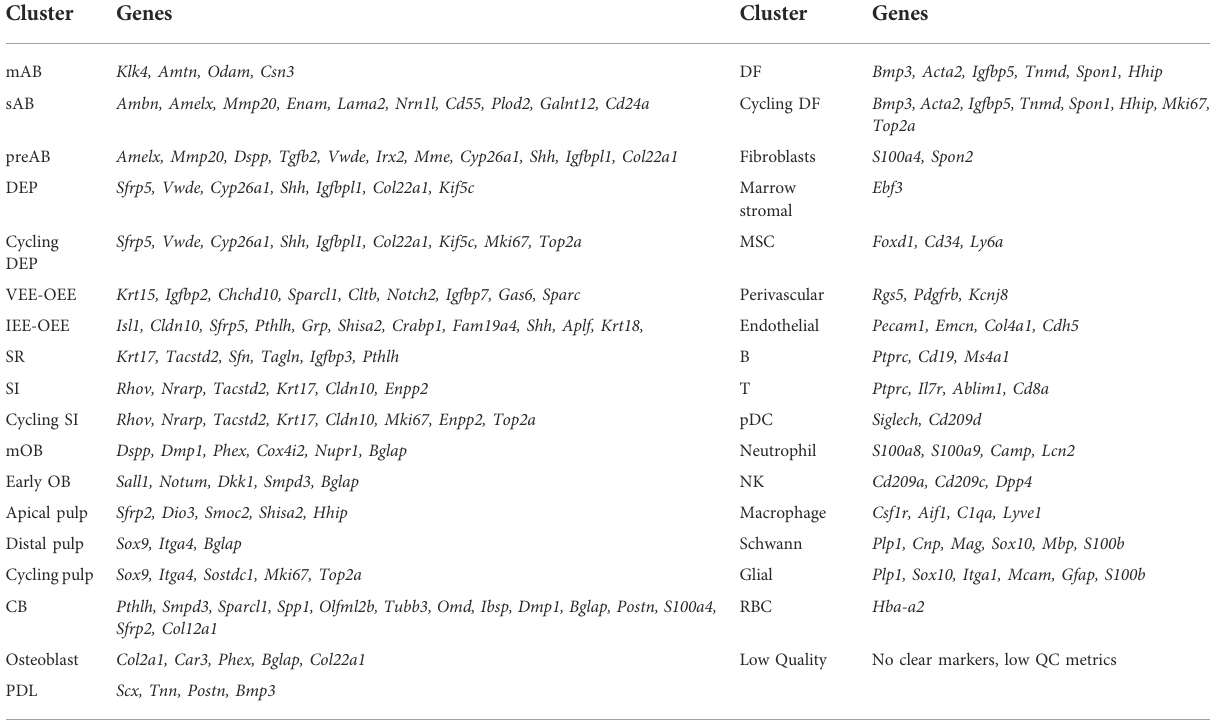
TABLE 3 Gene panels used for cluster annotation of mouse tooth cell